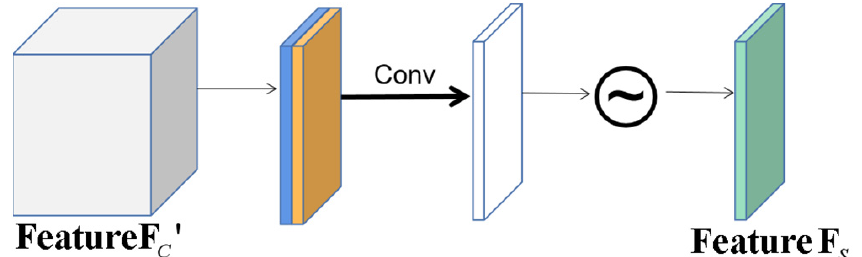
Figure 5. Spatial attention module.